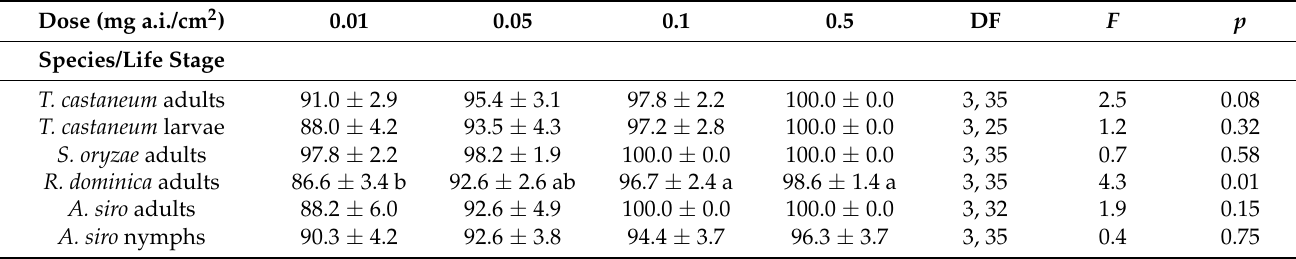
Table 9. Mean delayed mortality (% ± SE) of Tribolium castaneum adults and larvae, Sitophilus oryzae adults, Rhyzopertha dominica adults, and Acarus siro adults and nymphs exposed on concrete treated with chlorantraniliprole at four doses (0.01, 0.05, 0.1, and 0.5 mg a.i./cm 2 ). Within each row, means followed by the same lowercase letter are not significantly different (in all cases DF = 3, 35, Tukey–Kramer HSD test at p = 0.05). Where no letters exist, no significant differences were